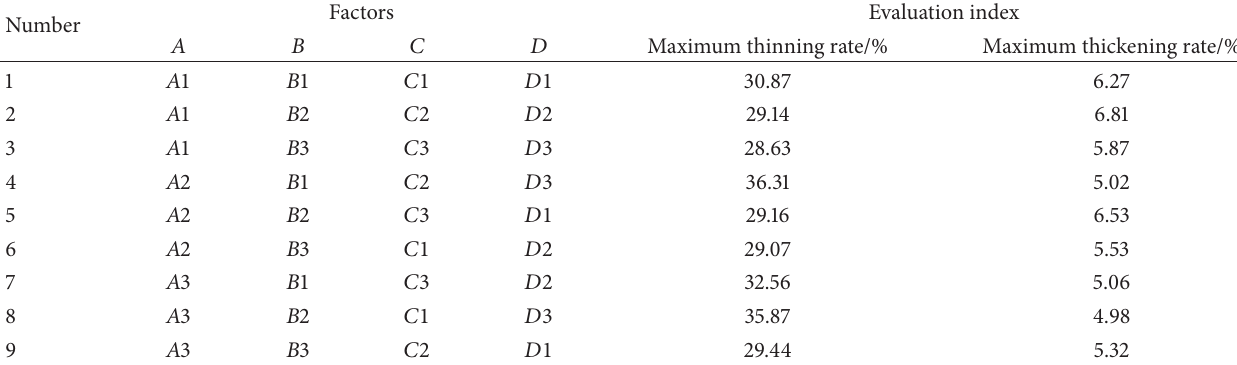
Table 4: Thickness reduction and thinness reduction data obtained by orthogonal experiment.